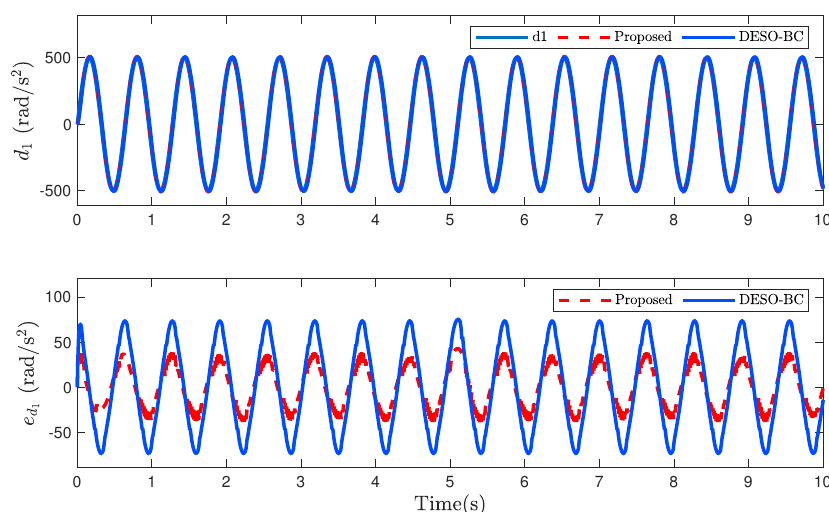
Figure 9. Lumped mismatched uncertainty estimation performances of all control approaches in case of step reference trajectory.